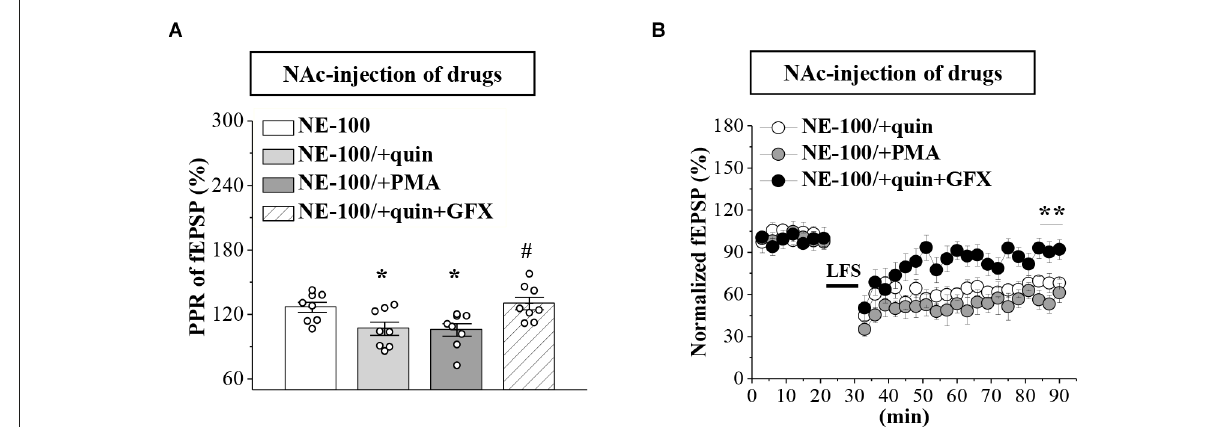
FIGURE5 Repeated injection of NE-100 impairs GABA A R-regulated LTD through reduced PKC activity. (A ) Bar graphs show the PPR (25 ms IPI) in the slices of NE-100 mice treated with NAc-injection of quinpirole (quin), PMA, or the co-administration of quinpirole and GF109203X (quin+GFX). * p < 0.05 vs. vehicle-treated mice; # p < 0.05 vs. quin-treated mice ( n = 8 slices/4 mice per group; one-way ANOVA). (B ) LTD induction in NE-100 mice treated with NAc-injection of quinpirole (quin), PMA, or the co-administration of quinpirole and GF109203X (quin+GFX). ** p < 0.01 vs. quin-treated mice ( n = 8 slices/4 mice per group; Mann-Whitney U